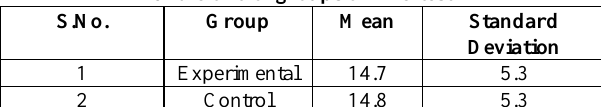
Table No 4.1: Mean and Standard Deviation of Experimental and Control groups on